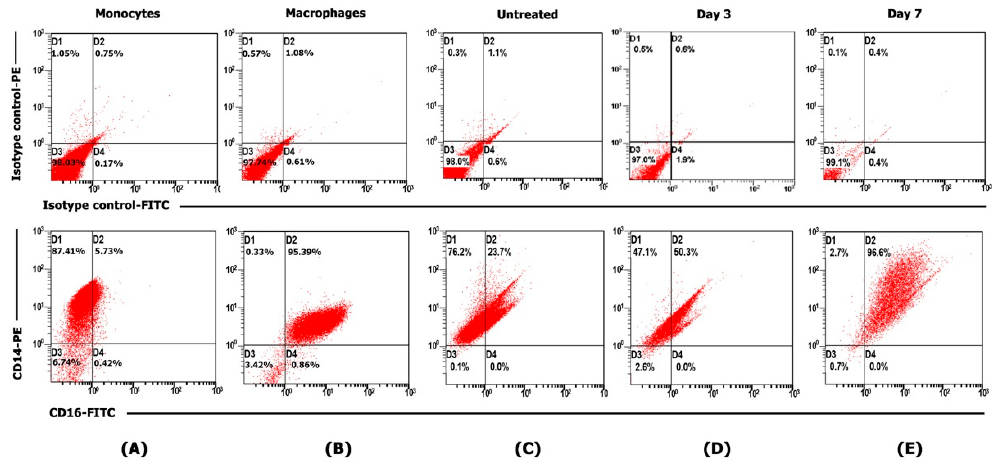
Figure 2. Dot plot of representative flow cytometry profiles on gated monocytes, macrophages, and THP-1 cell lines. ( A , B ) Purification of monocytes and macrophages, ( C – E ) Differential response to PMA by THP-1 in 7 days. Untreated: THP-1 in RPMI medium; Day 3: treated THP1 with PMA 5 ng/mL at day 3; Day 7: treated THP1 with PMA 5 ng/mL at day 7.